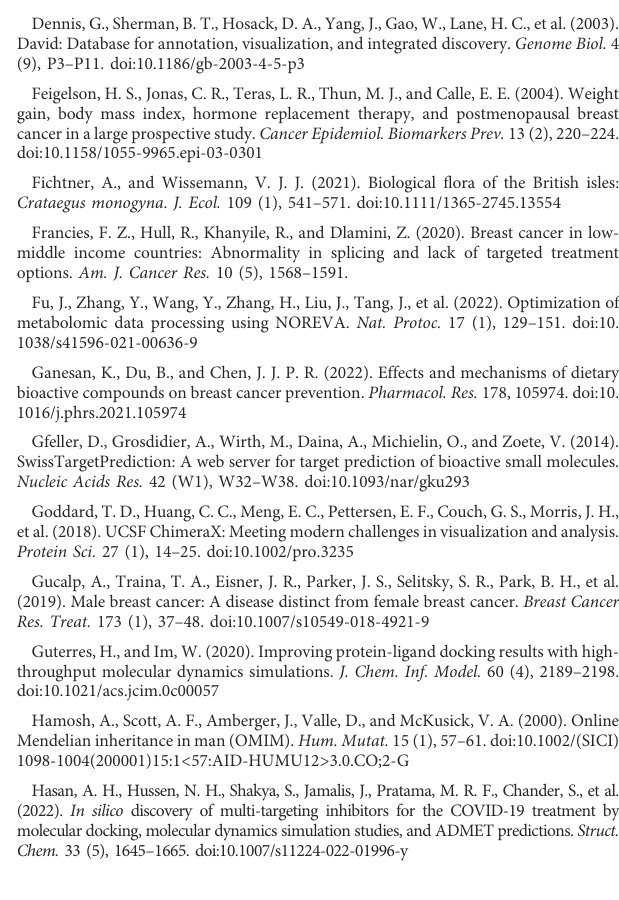
SUPPLEMENTARY TABLE S1 2D interactions of the target protein